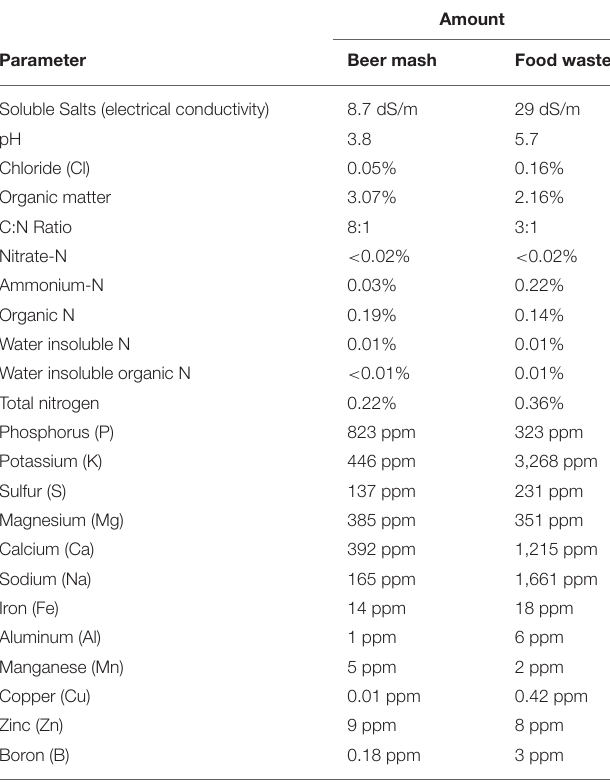
TABLE 1 | Nutrient analysis of Beer Mash and Food digestates used as amendment for all greenhouse experiments.